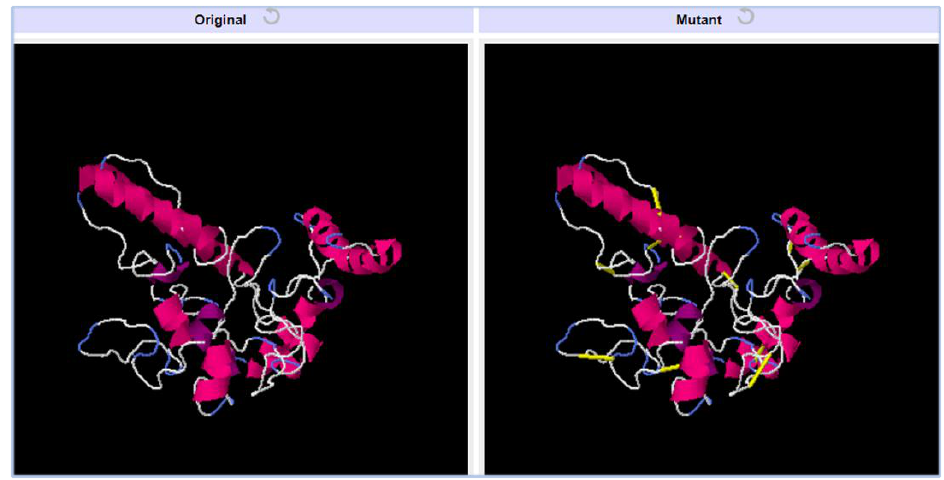
Figure 8. Vaccine constructs with mutated structure. Yellow bands in the mutant structure indicate disulfide bonds were introduced.